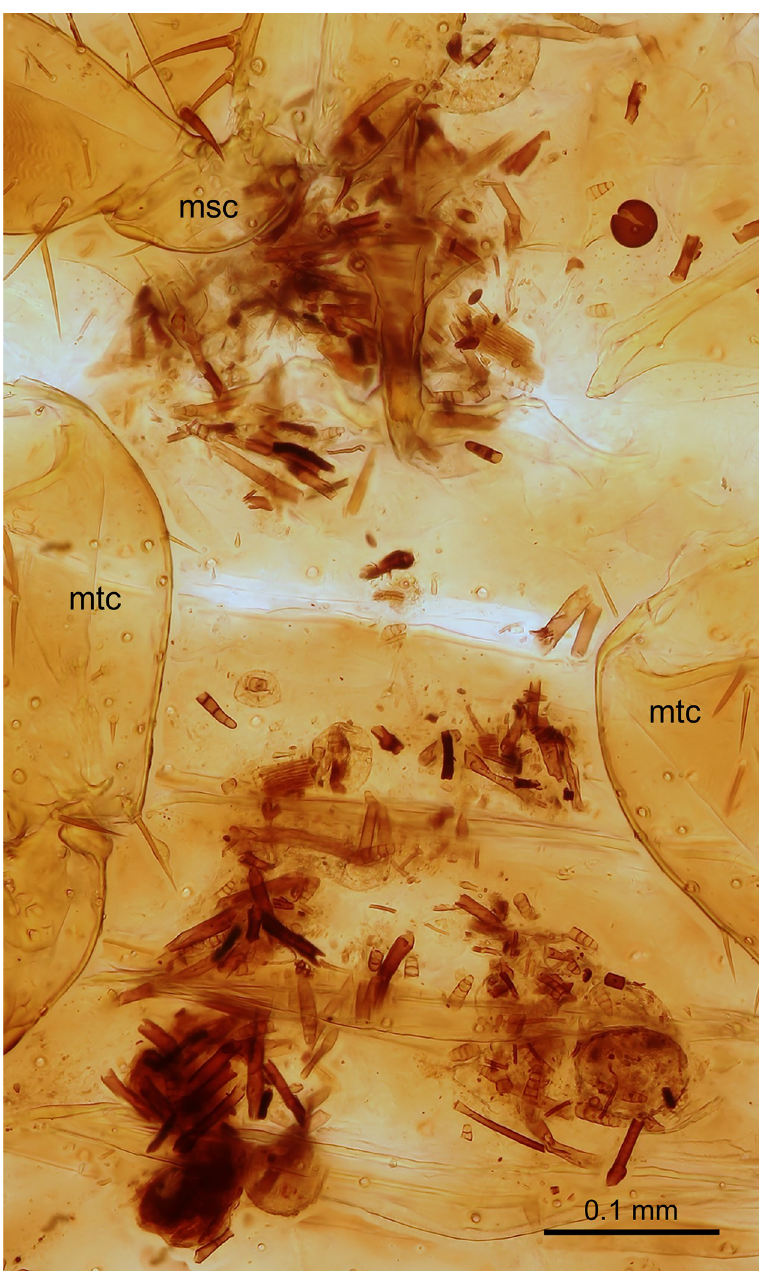
Fig 5. Latinozoros cacaoensis sp. nov., gut content inside male paratype abdomen, ventral view. Abbreviations: msc–mesocoxa; mtc–metacoxa. Scale bar = 0.1 mm. mm, cerci length 0.16 mm. Body color pale brown; legs, cerci and membranous regions lighter. Head subtriangular, longer than wide (Fig 6A), slightly wider than pronotum, distal edge con- vex medially; cephalic setae (Fig 6A) short and sparse, not grouped; compound eyes and ocelli absent, vestigal eyespots visible; cephalic gland present in centre of head, with several short setae; antennae 9-segmented (Fig 6F); antennomere I slightly curved outward, as well as anten- nomere II, antennomere II short, about one-third length of antennomere I; antennomere III